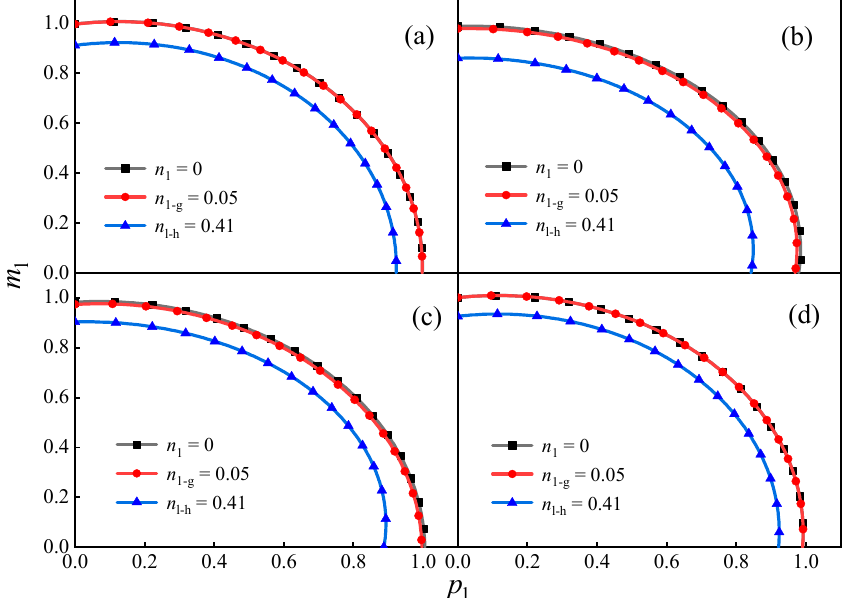
Figure 12. The effect of axial force on the limit load curves of straight pipes with local wall-thinning defects under the combination of internal pressure and bending moment: ( a ) axial defect; ( b ) circumferential defect; ( c ) large-area defect; ( d ) small-area defect. Table 11. The relative reduction in the average radius of the limit load curves of straight pipes with local wall-thinning defects under the influence of axial force.